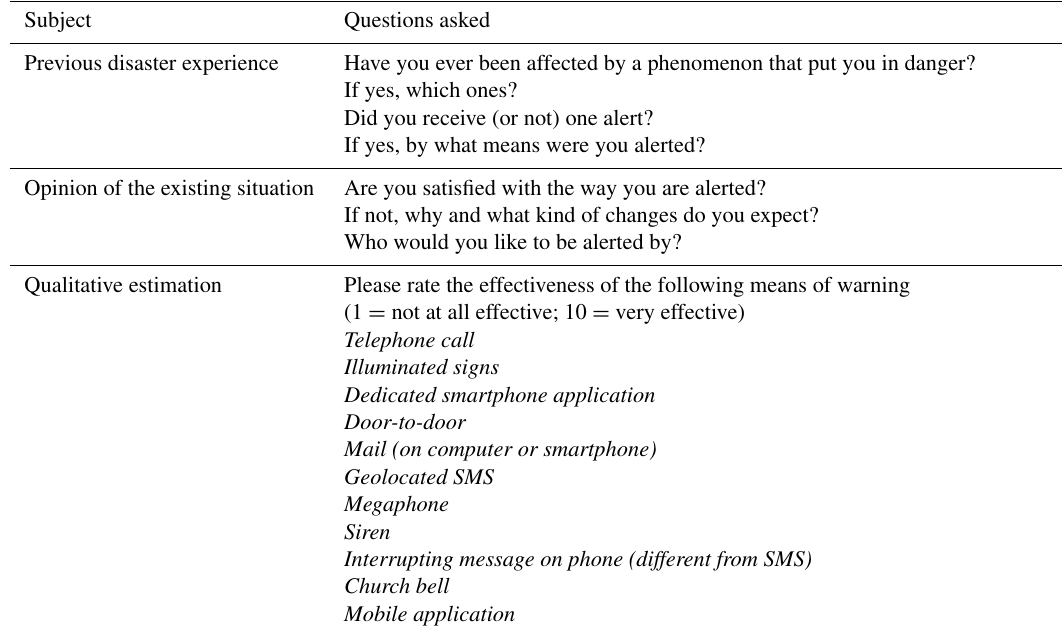
Table B1. Questions included in the online questionnaire done by 891 people to assess their trust in different alert